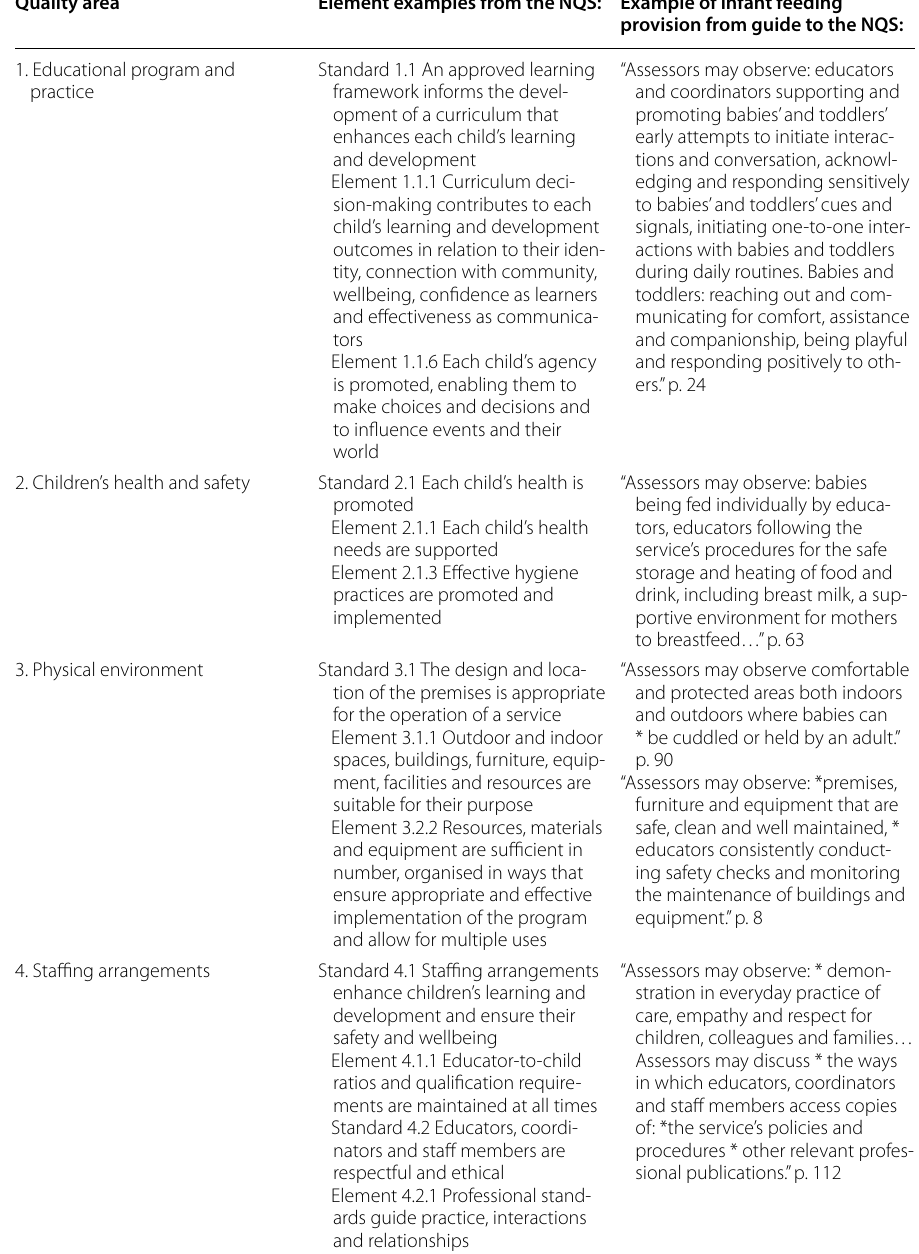
Table 2 National Quality Standard and infant feeding summary (Australian Children’s Education & Care Quality Authority (ACECQA) 2017a, b) Quality